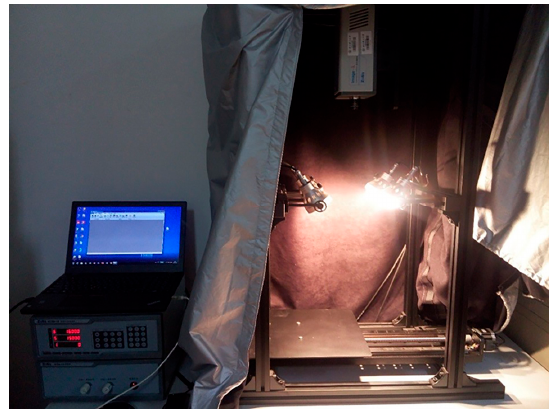
Figure 1. Hyperspectral imaging system.